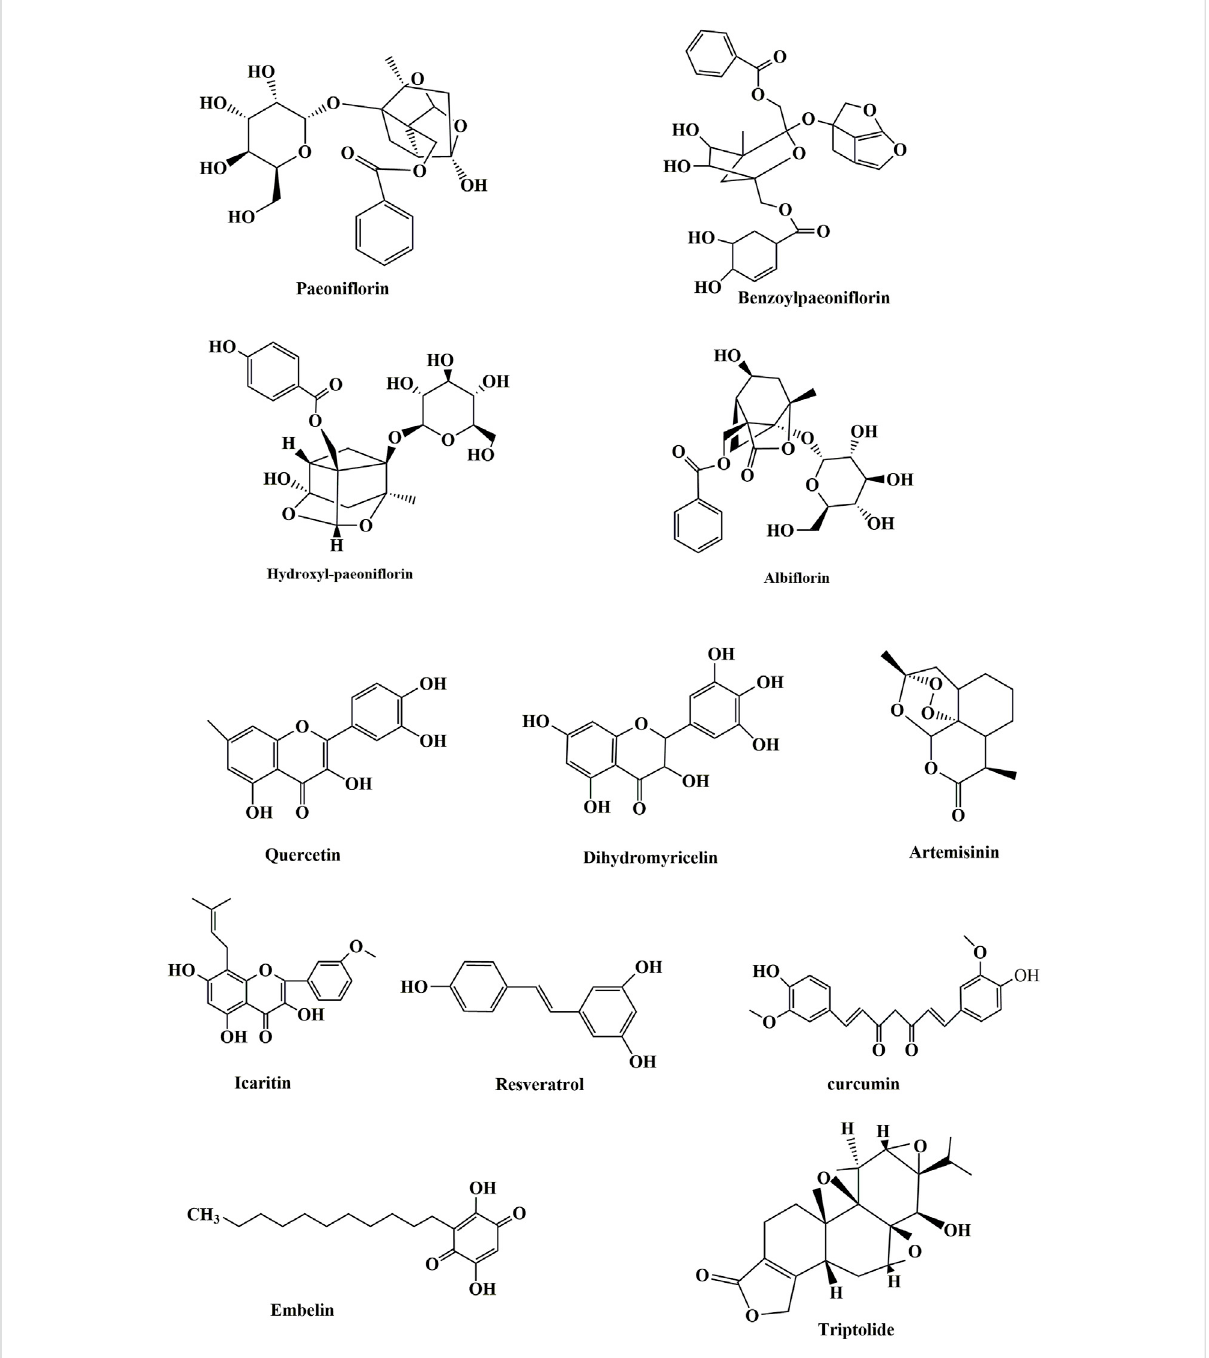
FIGURE 3 Chemical structures of some